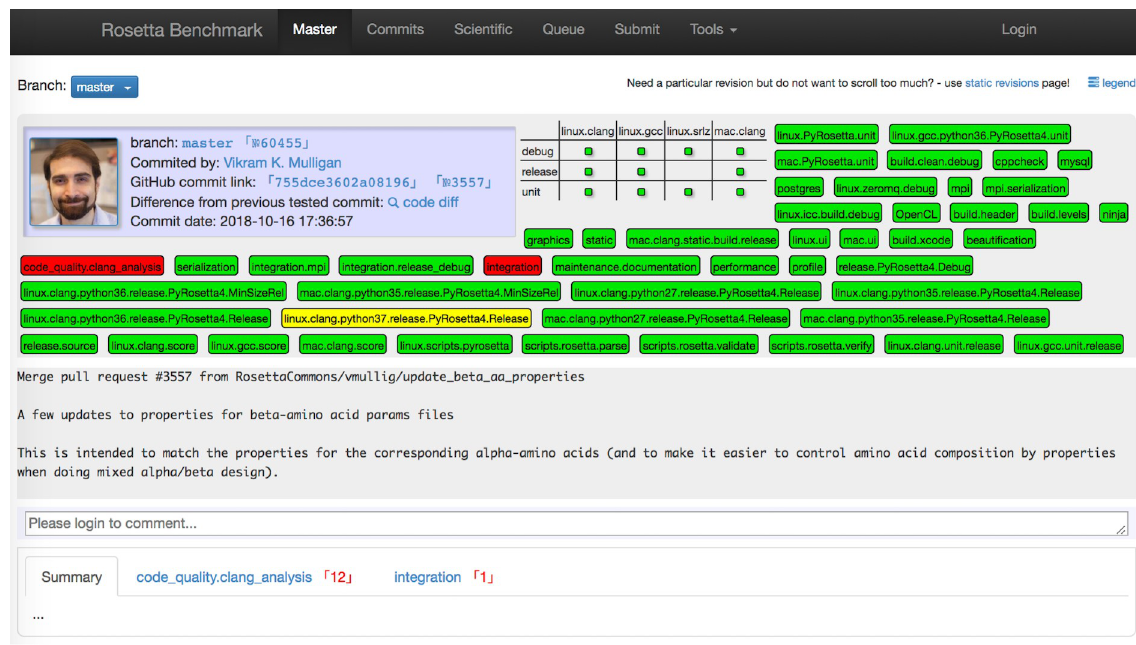
Fig 4. Software testing. Testing is essential to ensure stability and correctness of software. This is a view of our testing server dashboard for a specific merge into the master branch of Rosetta. We continuously run a large number of tests, such as build tests, unit tests, integration tests, performance tests, code analysis tests, and scientific benchmarks. Tags in green, red, and yellow denote test pass, failure, and currently